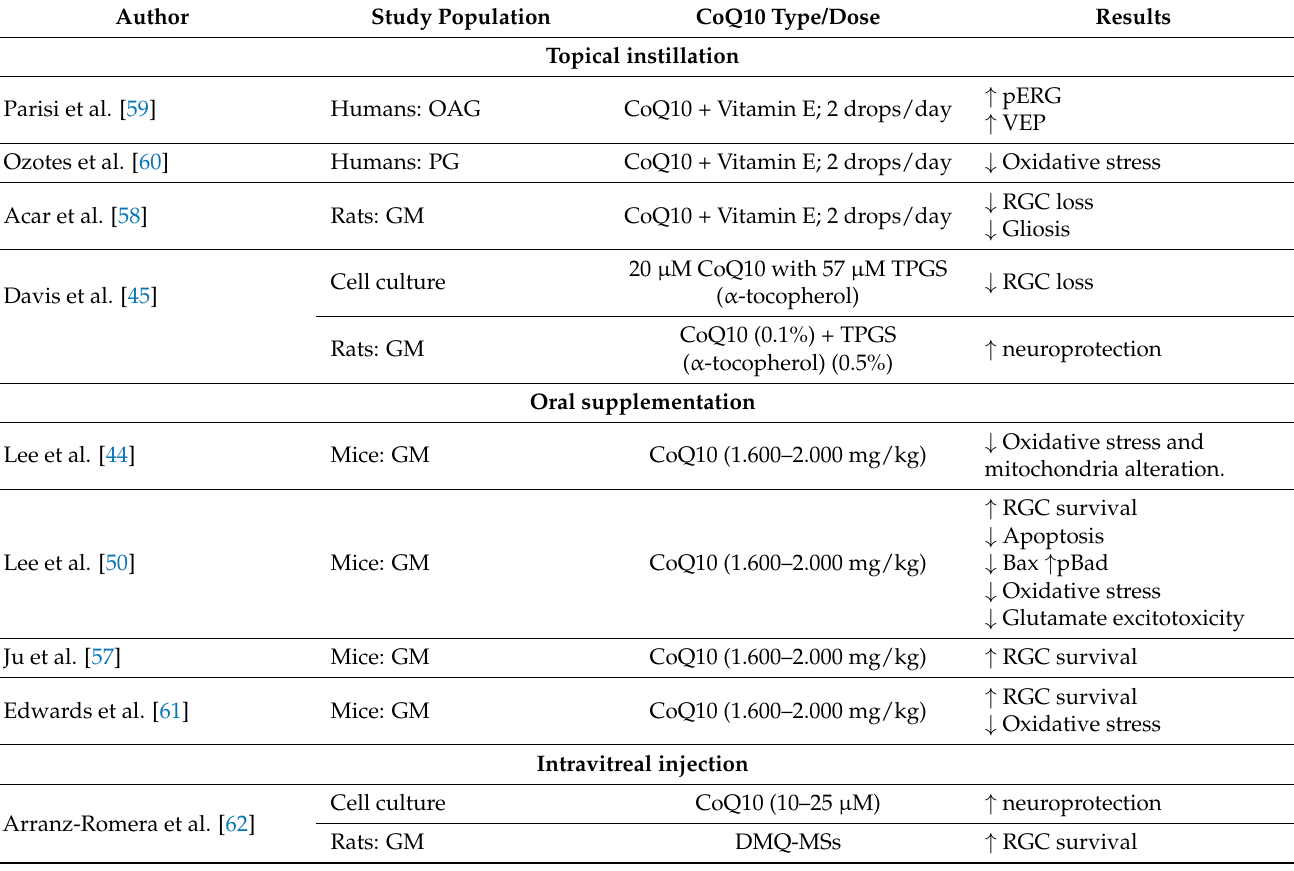
Table 3. Summary of articles that relate CoQ10 to glaucoma, classified according to administration